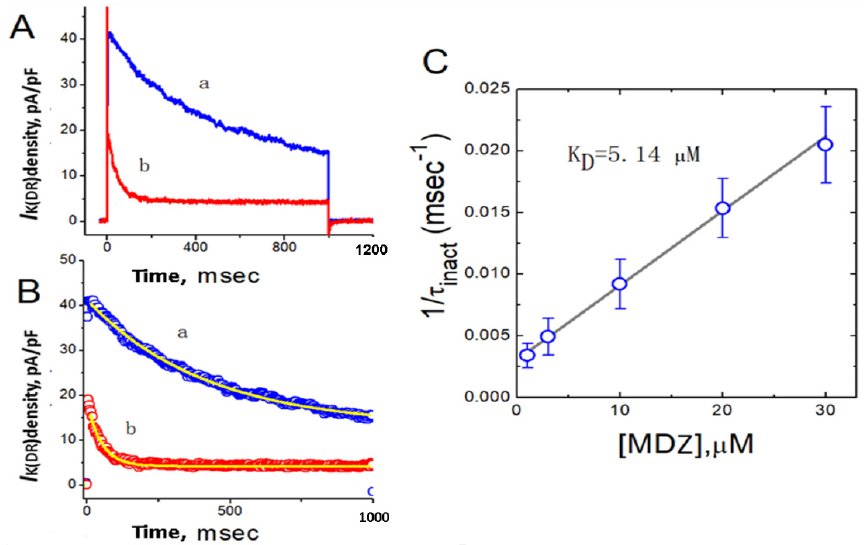
Figure 4. Evaluation of the kinetics of MDZ-induced block of I K(DR) density occurring in Jurkat T-lymphocytes. In ( A ), the inactivation time courses of I K(DR) density in the absence (a) and presence of 30 µ M MDZ (b) were well fitted by a single-exponential shown in ( B ). In these experiments, the cell examined was depolarized from − 50 to +50 mV with a duration of 1 sec. In ( C ), the kinetics of MDZ-induced block of I K(DR) density in these cells was evaluated. The reciprocal of inactivation time constant of I K(DR) density (1/ τ inact ) obtained by exponential fit of the I K(DR) trajectory was reliably derived and plotted against the MDZ concentration. The experimental data points were fitted by a linear regression, indicating that MDZ-induced block occurs with a molecularity of 1. Blocking ( k +1 ) and unblocking ( k − 1 ) rate constants, given by the slope and the y -axis intercept of the interpolated line, were 0.000602 msec − 1 M − 1 and 0.0031 msec − 1 M − 1 , respectively, and the K D value ( k − 1 / k +1 = 5.14 µ M) was generated. Each point in ( C ) represents the mean ± SEM ( n = 11–14).